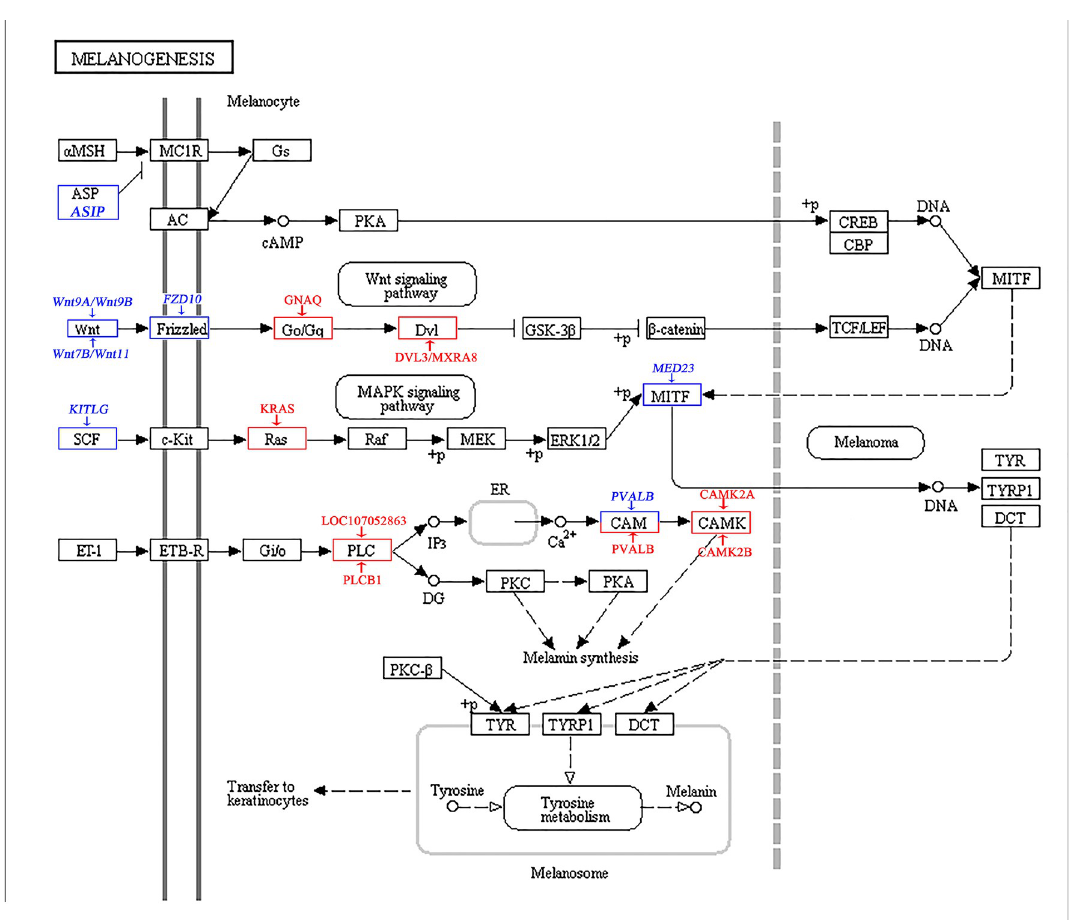
Fig 8. Differentially expressed feather color genes and proteins identified in the analyzed chicken feather follicles and their involvement in the melanogenesis pathway. DEGs have a blue frame, and the DEPs have a red frame.